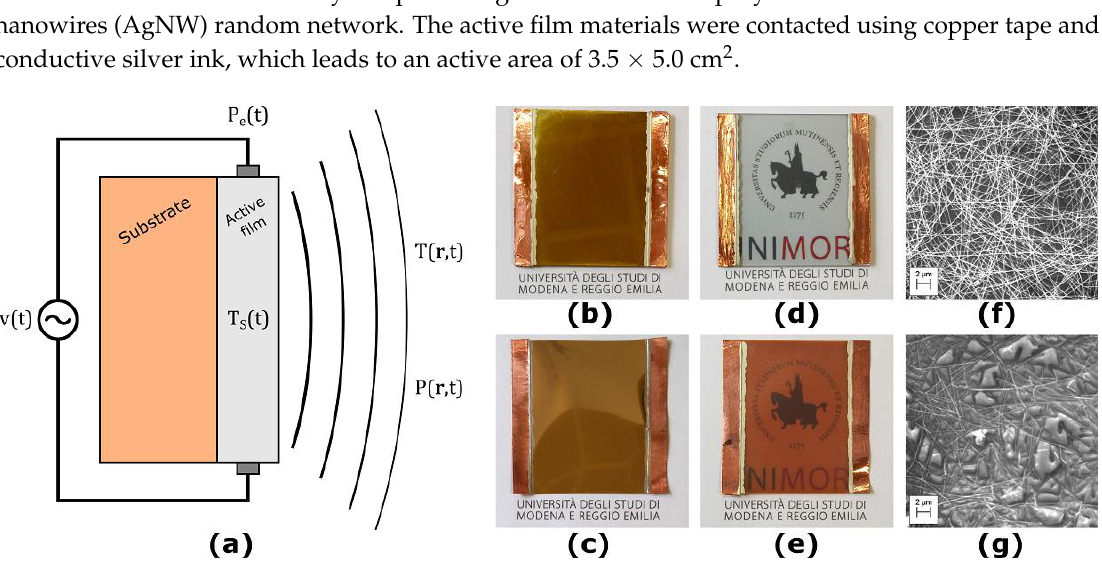
Figure 1. The considered thermoacoustic (TA) loudspeakers. ( a ) Structure of the TA loudspeakers; ( b ) sample with gold active film on glass substrate; ( c ) sample with gold active film on Kapton substrate; ( d ) sample with silver nanowires (AgNW) active film on glass substrate; ( e ) sample with AgNW active film on Kapton substrate; ( f ) SEM-image of the AgNW active film on glass substrate; ( g ) SEM-image of the AgNW active film on Kapton substrate.